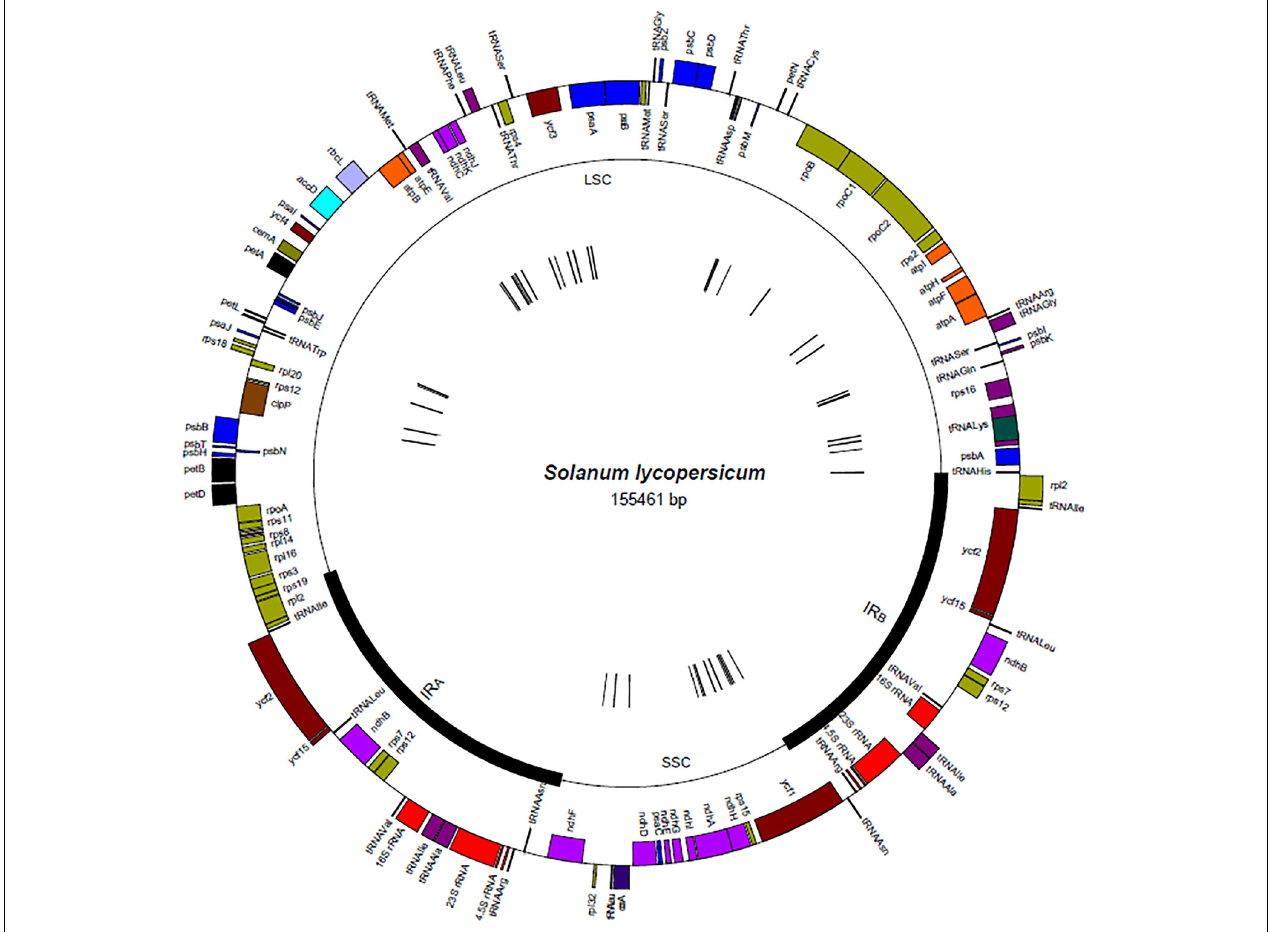
FIGURE 7 | The location of the S. lycopersicum specific k-mer clusters in the chloroplast genome (in sequence NC_007898.3). The outer circle illustrates the location of the chloroplast genes and the middle circle indicates the location of the inverted repeats (IR A and IR B ) and single copy regions (SSC and LSC). The location of the 42 different clusters of S. lycopersicum specific k-mers are shown as small black strokes in the inner circle in the